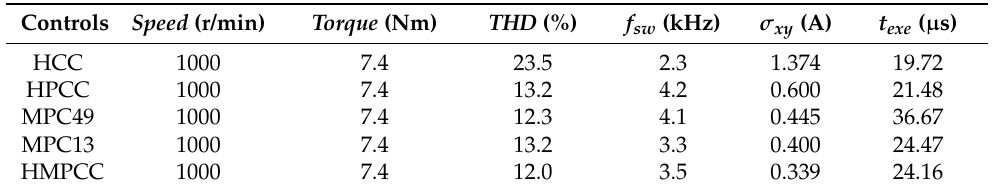
Table A1. Summary of the performance indicators for the control strategies applied to the asymmet- rical six-phase IM (Test 1).